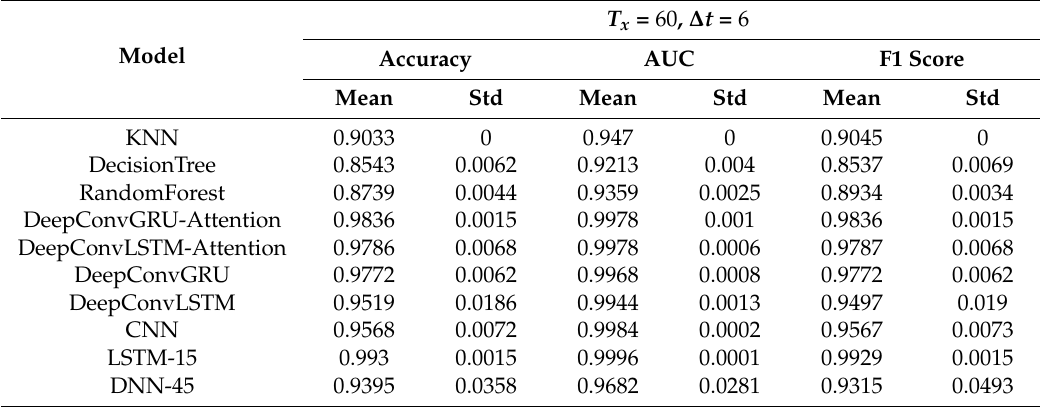
Table 5. Driving behavior identification for different methods when setting T x to 60 samples and ∆ t to 6